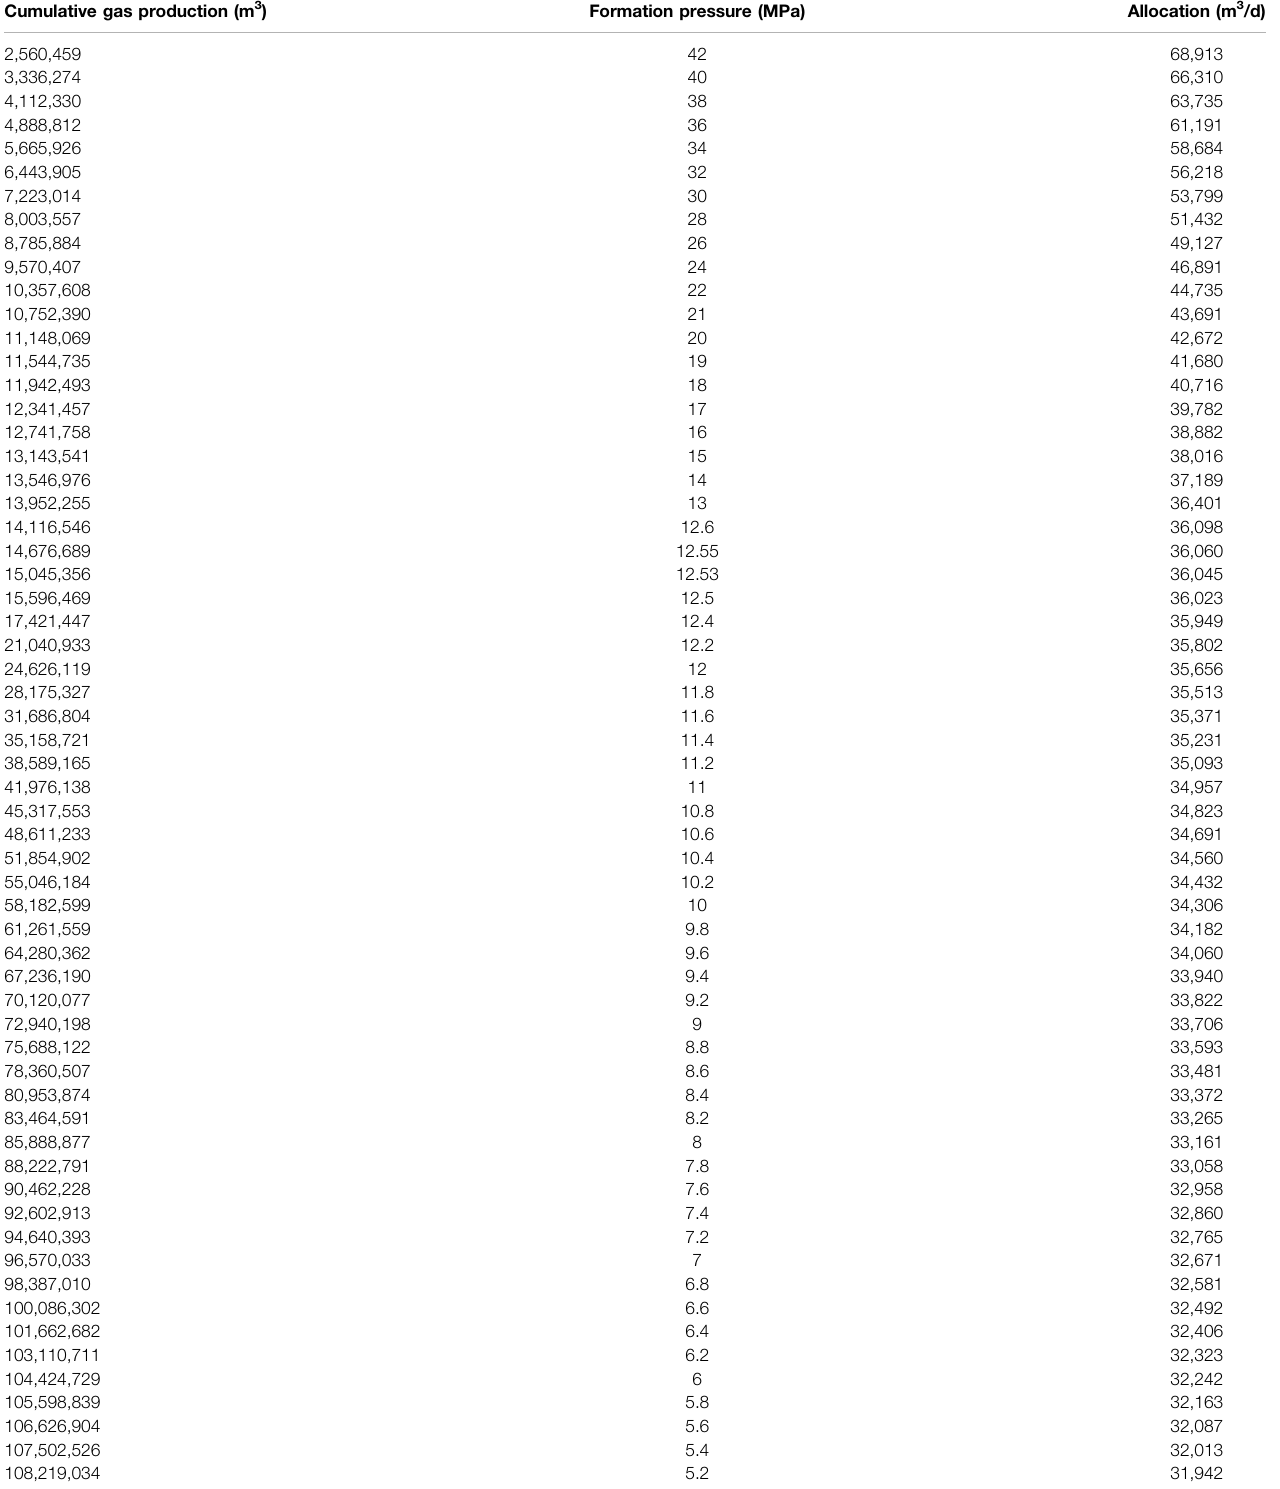
TABLE 3 | Cumulative gas production versus the formation pressure and single well allocation production. Cumulative gas production (m 3